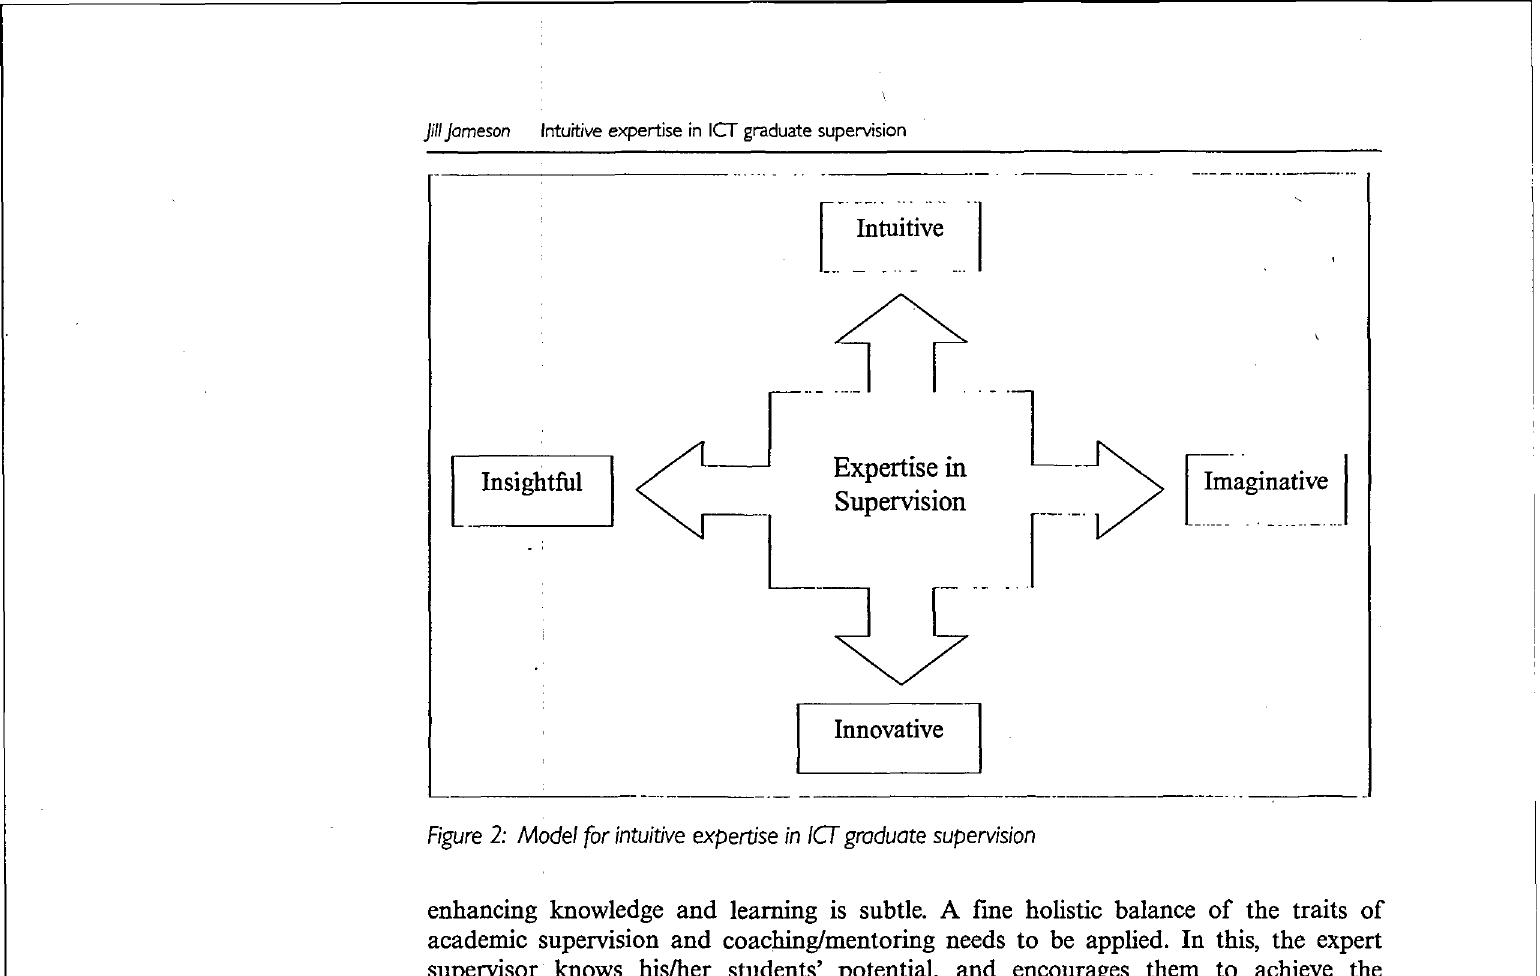
figure 2: Model for intuitive expertise in Id graduate